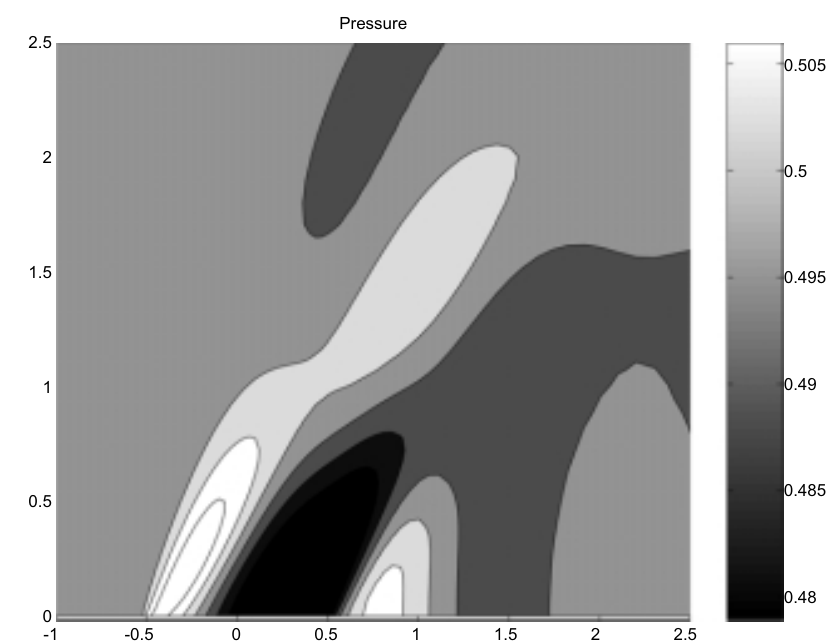
Fig. 21. Pressures after 20 second simulation using 8 modes with δ 1 = 0 . 01 .